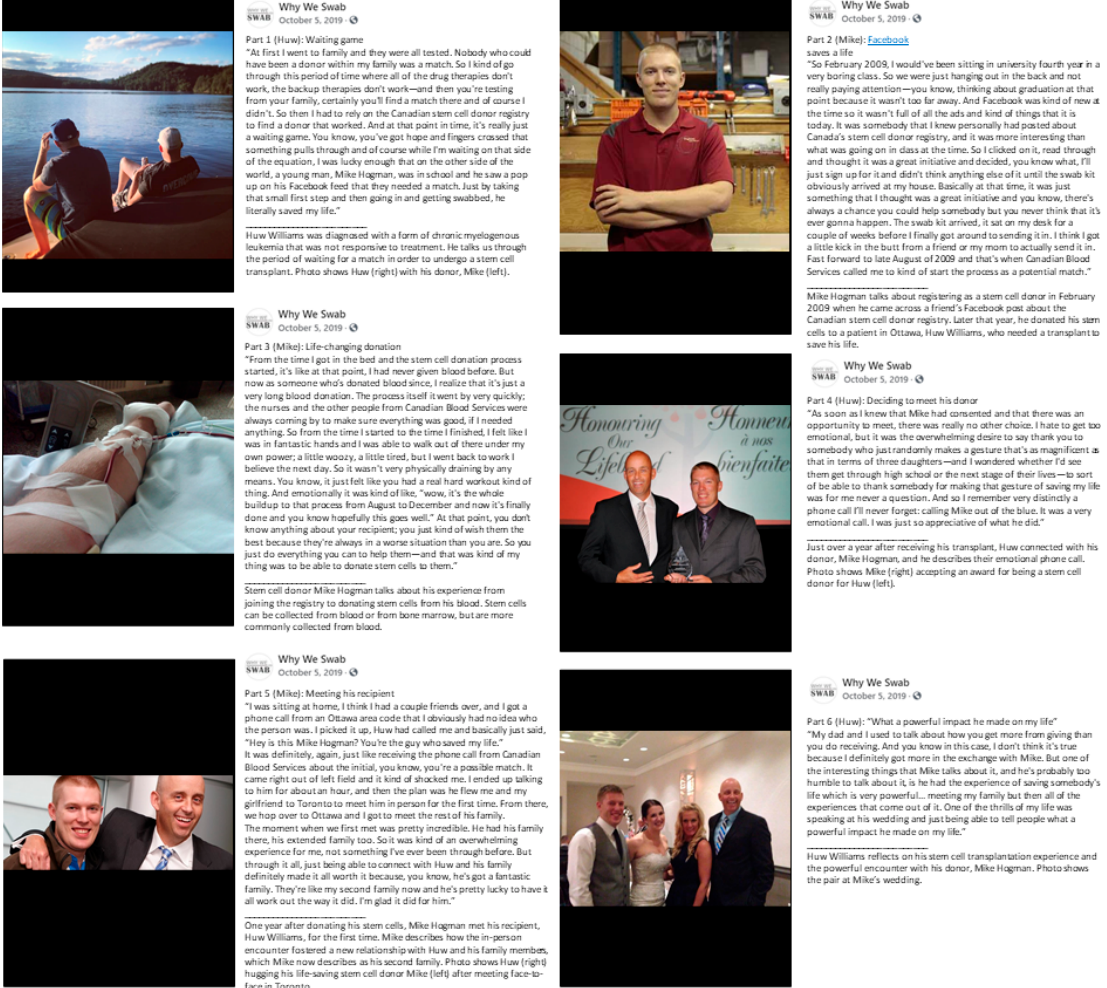
Figure 1 : This donor–recipient story is one of several stories regarding stem cell donation by Why We Swab, a library of Canadian stories in stem cell donation (Facebook, Instagram, and